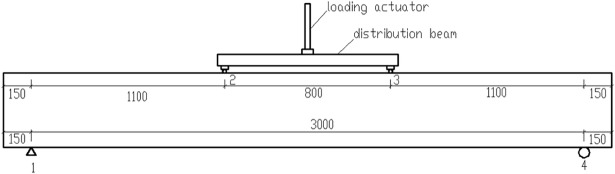
Loading schematic.